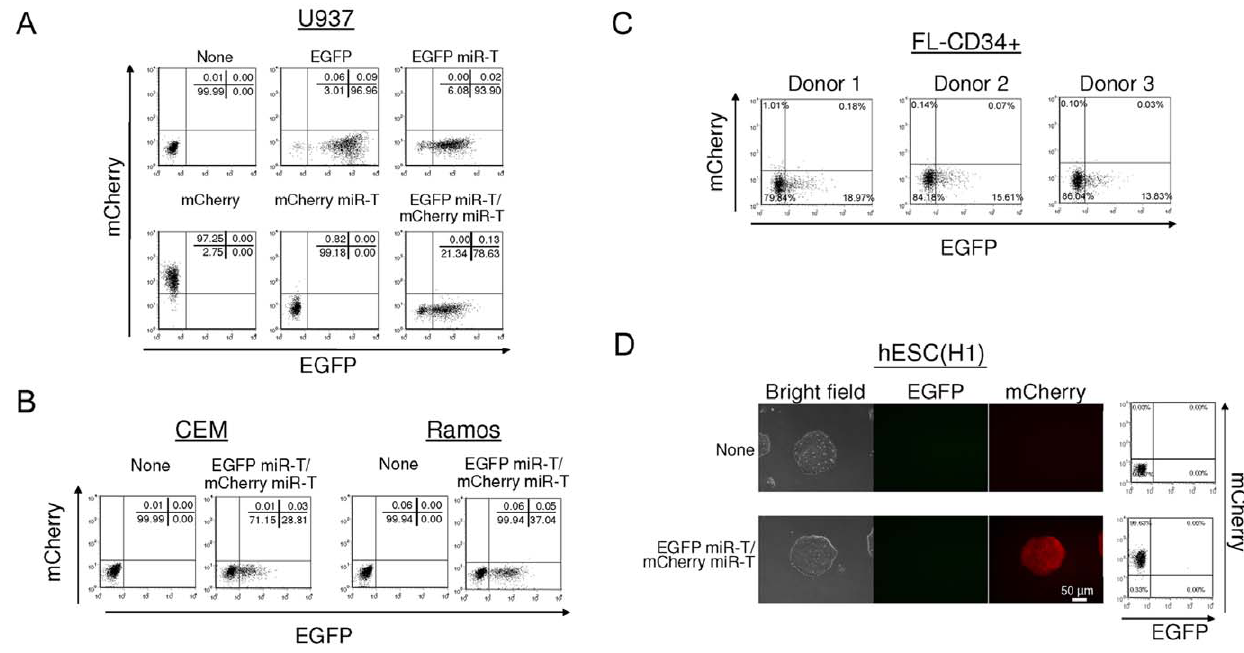
Figure 2. The reporter vectors containing miRNA targets show the lineage-specific expression. (A) U937 cells were infected with lentiviral vectors encoding various reporters showed in Fig. 1 A. Expression levels of EGFP and mCherry were analyzed by flow cytometry 2 days post- infection. (B and C) CEM and Ramos cells (B) and CD34 + HPSCs derived from 3 independent donors (C) were infected with a lentiviral vector encoding EGFP miR-T/mCherry miR-T. Expression levels of EGFP and mCherry were analyzed by flow cytometry 2 days post-infection. (D) hESCs (H1) were infected with a lentiviral vector encoding EGFP miR-T/mCherry miR-T. Single cell clone was isolated by culturing transduced cells in the presence of 10 m M Y27632 for 14 days. Expression levels of EGFP and mCherry were analyzed by fluorescence microscopy and by flow cytometry. The number (%) in each quadrant is listed on each plot.